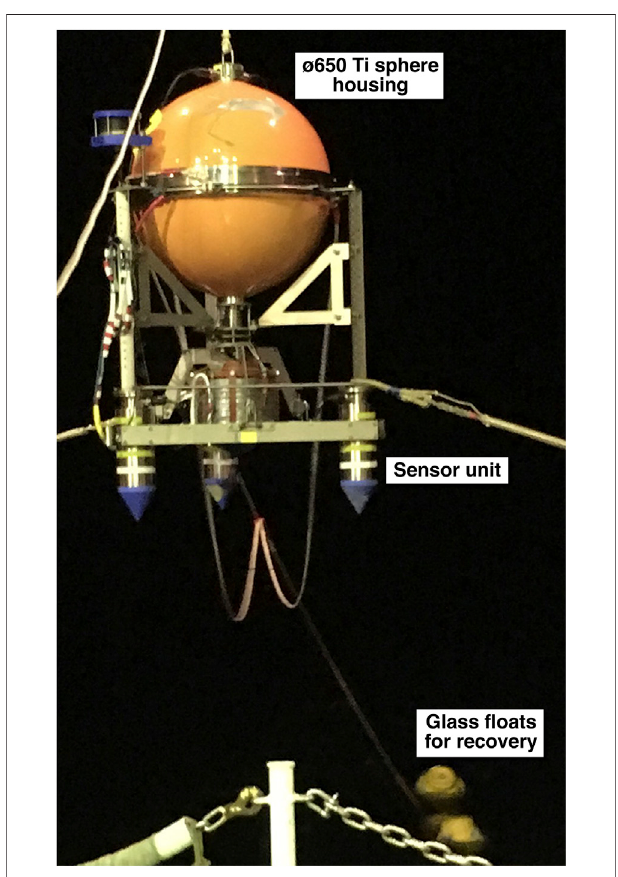
FIGURE 4 | The NX-2G, autonomous type of the BBOBS-NX. To achievethesameperformanceoftheBBOBS-NXwithoutaidofsubmersibles, the autonomous type is in the fi nal feasibility